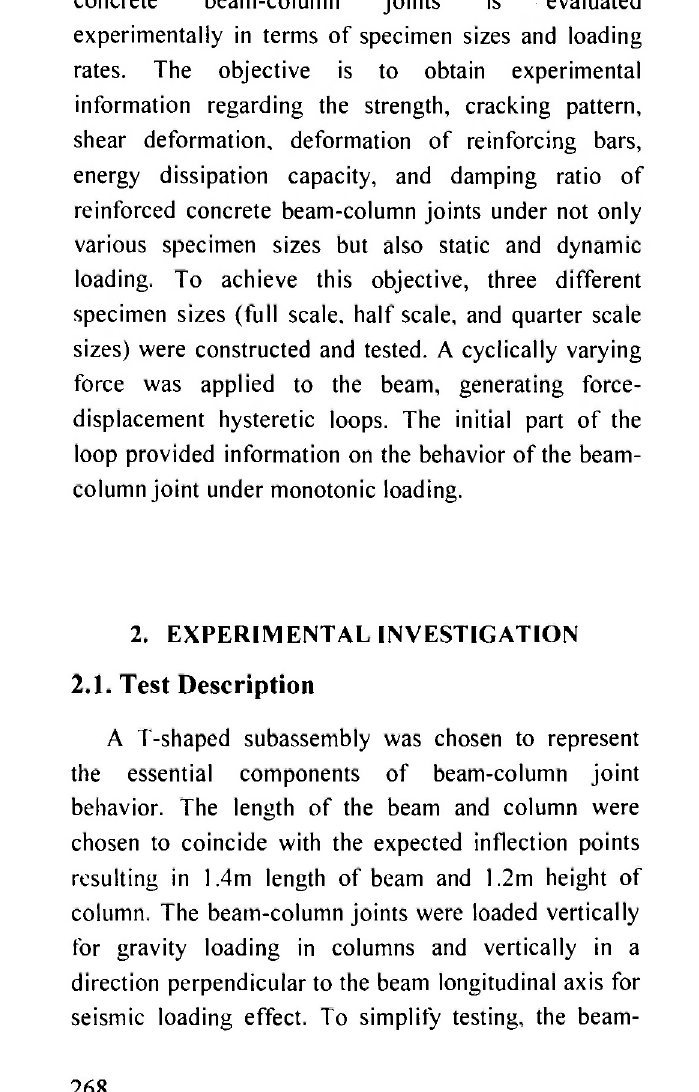
Fig. 1 : Test set-up for beam-column joint subassembly